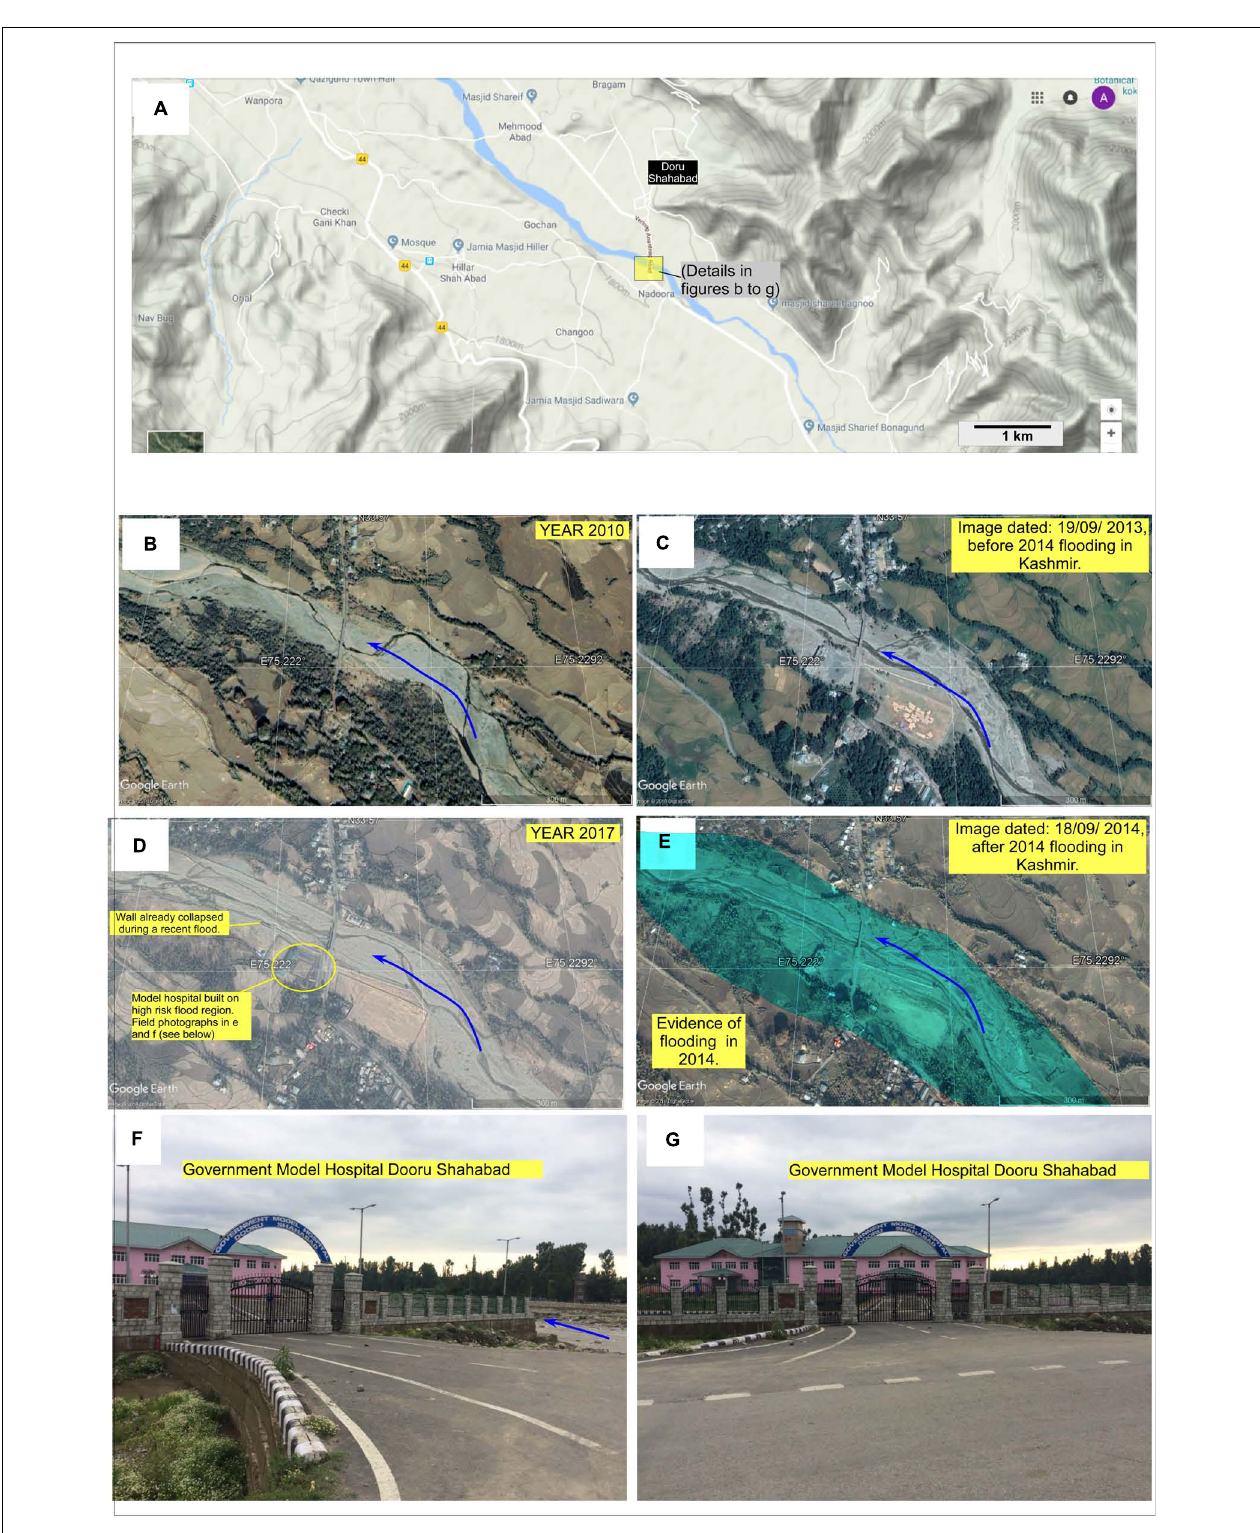
FIGURE 4 | The Google terrain image (A) shows the location of a newly constructed government hospital in Dooru, Anantnag, Kashmir. Subsequent figures (B–E) show the historical satellite images of the area and highlight the reckless attitude of authorities to build a new hospital right on the active flood plain area of the stream that was recently flooded in 2014. The field photographs of the hospital building are also shown (F,G) . The first figure (A) is obtained from Google maps on 20th July 2018, and subsequent figures (B–E) are also acquired on the same date from Google Earth that uses images from Digital Globe.